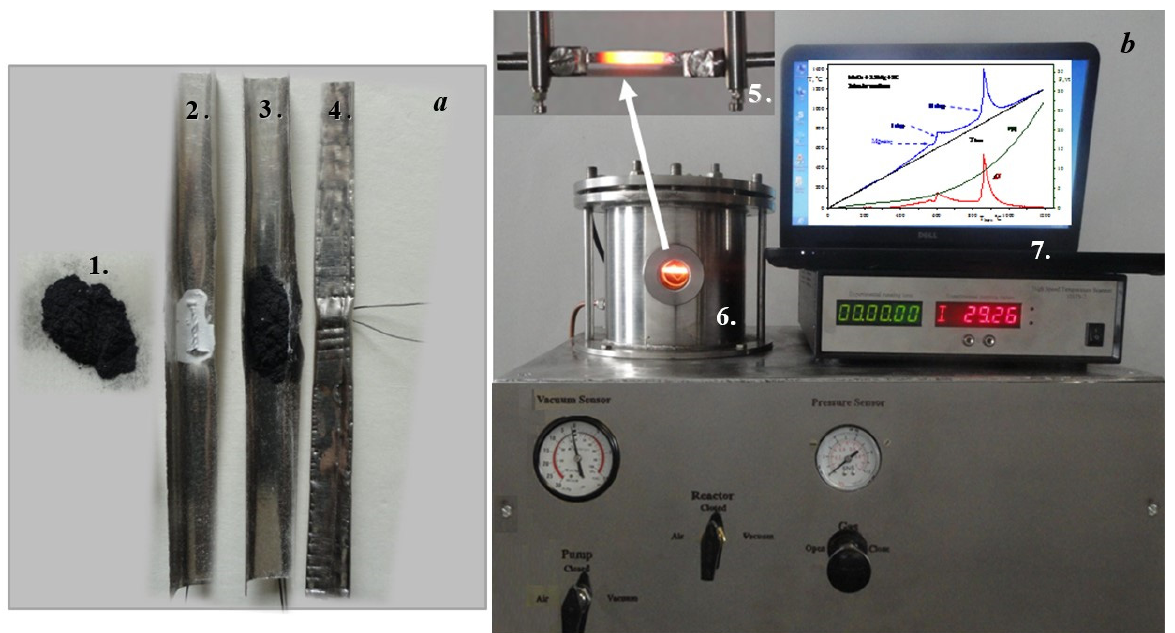
Figure 1. The experimental steps for the kinetic studies using high-speed temperature scanner. ( a ) Envelope heater with reactive mixture under study; ( b ) reaction chamber and controller: 1—reactive mixture, 2—boat made from nickel foil, 3—powder mixture in Ni boat, 4—envelope with mixture and thermocouple wire, 5—heated sample, 6—reaction chamber, 7—electronic unit and PC for control and registration.